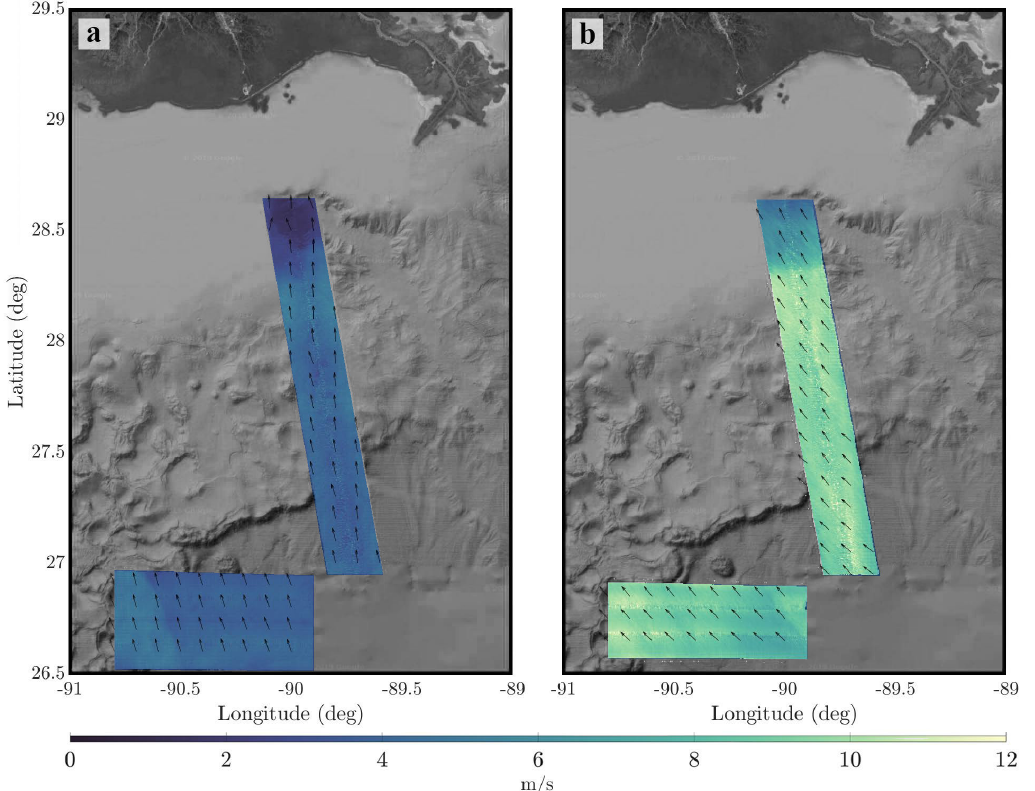
Figure 8. Wind speeds and directions as estimated by DopplerScatt for ( a ) March 25th and ( b ) 26th. Data shown are averaged over all flight lines for each date and vectors are decimated by a factor of 25. Figure 9, top zooms on the wind field as estimated by DopplerScatt on the 25th for the East-West flight lines. The two flight lines that were pieced together to form this mosaic were taken about 45 min apart, leading to the discontinuity in wind speeds along the center of the image. The strong